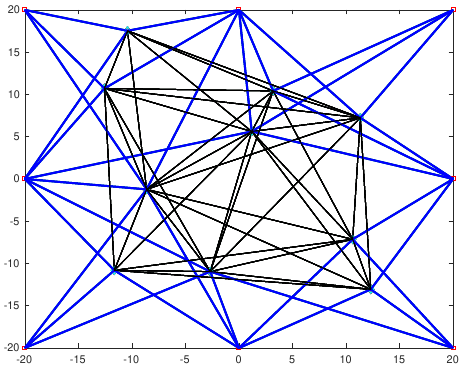
Figure 1. The cooperative source localization geometry of the anchor nodes and source nodes. The eight squares represent the anchor nodes, and the ten diamonds represent the source nodes. The blue lines represent the connections between anchor nodes and source nodes, and the black lines represent the connections between source